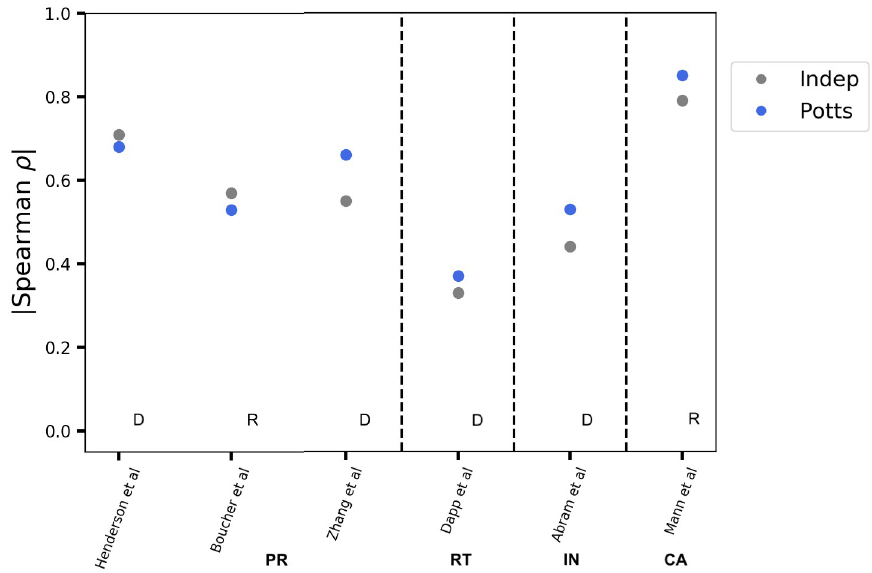
Fig 4. Survey of correlation between sequence-based predictions and experimental measures of “fitness” based on replicative capacity. Spearman correlation coefficients, ρ between prevalence-based measures of fitness as predicted by the Potts (blue) and independent (gray) models and experimental measurements related to replicative capacities are shown across four different HIV proteins: PR, RT, IN, and p24 CA. Experimental data are obtained from [3, 21, 28, 39–41]. Experiments reporting fitness measurements for random mutations are marked with an “R” and experiments reporting drug-resistance only mutations are marked with a “D”. Correlation is not consistent between different experiments for the same protein. The Potts model generally (marginally) outperforms the independent model in capturing experimentally measured replicative capacities or measures related to replicative capacities.